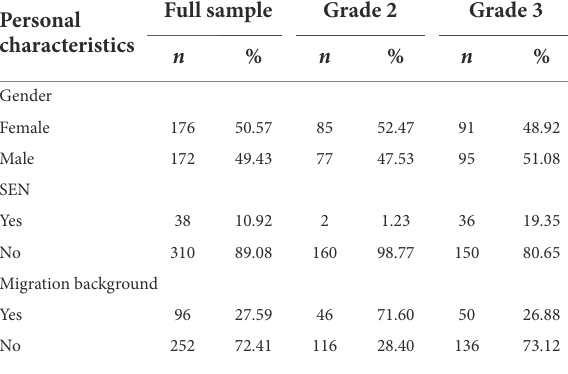
TABLE 1 Sociodemographic of students at the start of the